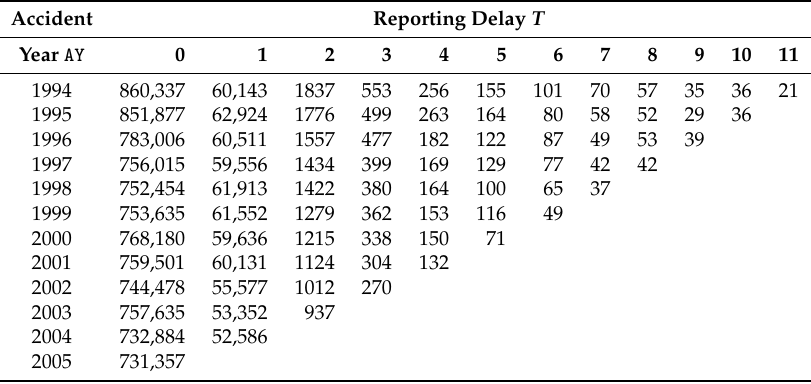
Table 3. Triangle of reported claims of the simulated